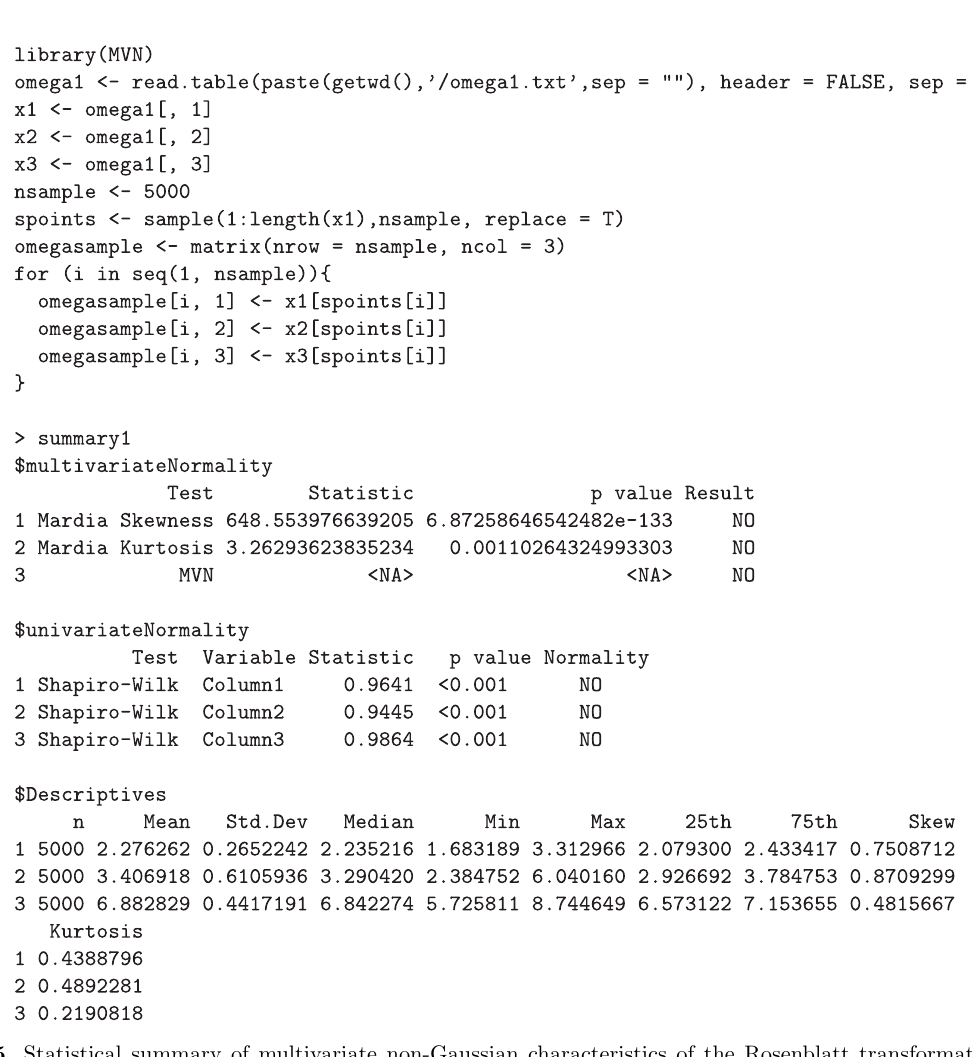
Fig. 5. Statistical summary of multivariate non-Gaussian characteristics of the Rosenblatt transformation system Monte Carlo data using the Mardia normality